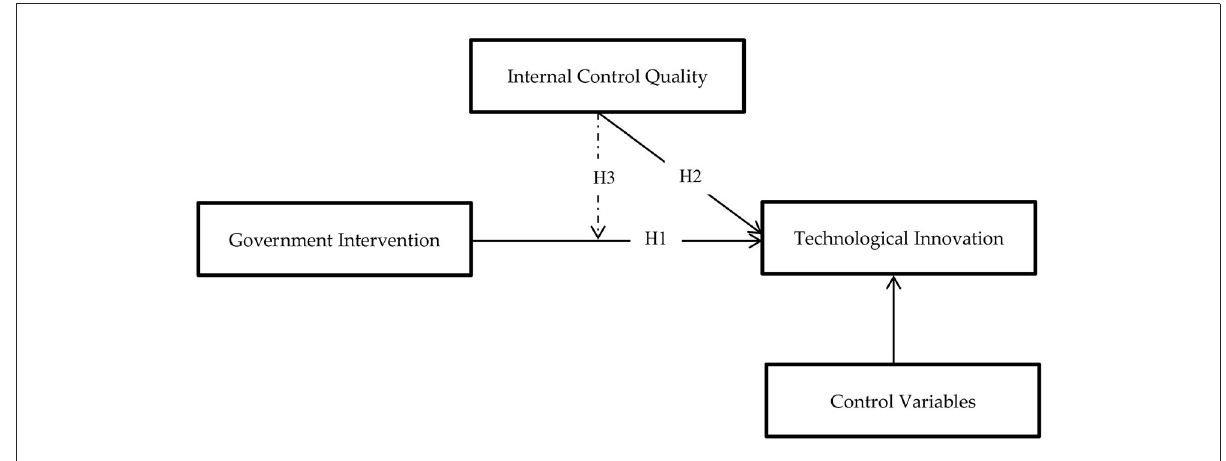
FIGURE1 Theoretical